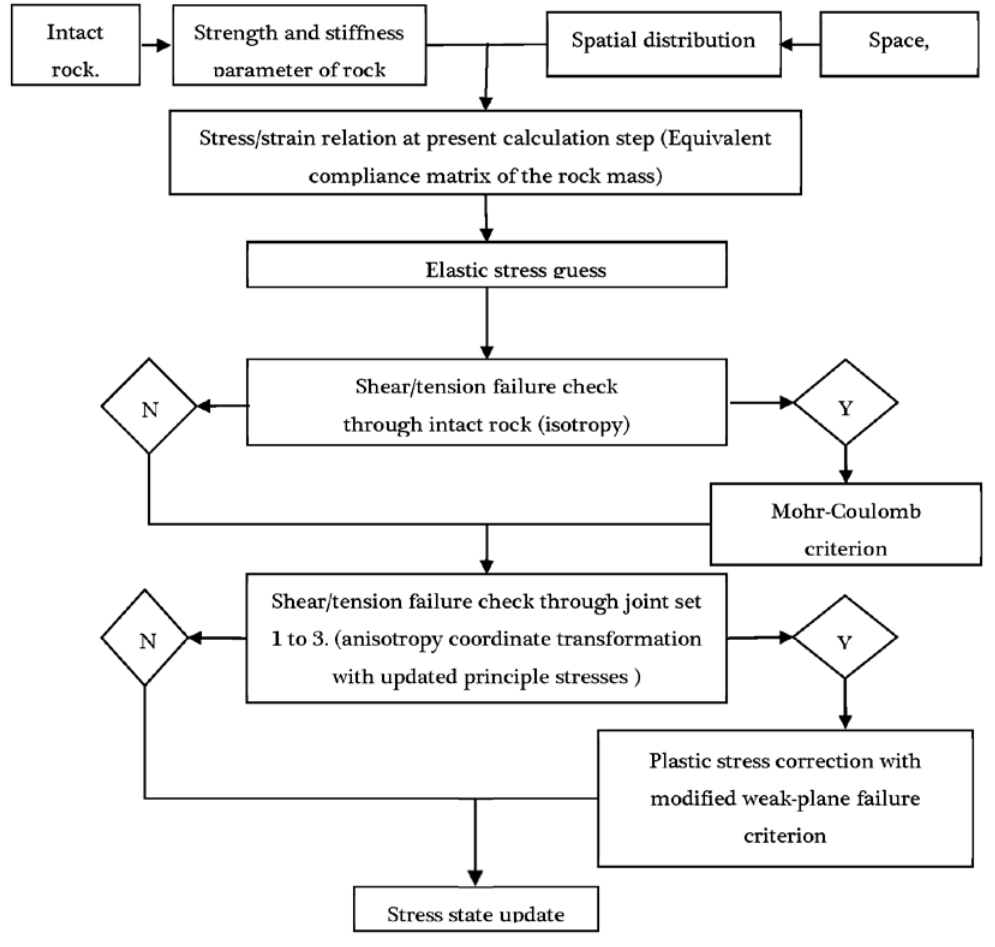
Figure 12. Flowchart for equivalent continuum multi-joint model.